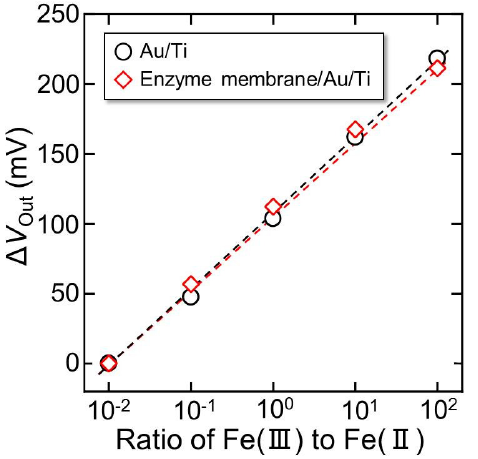
Figure 5. Δ V Out of the sensor plotted against the concentration ratio of Fe (III) to Fe (II).